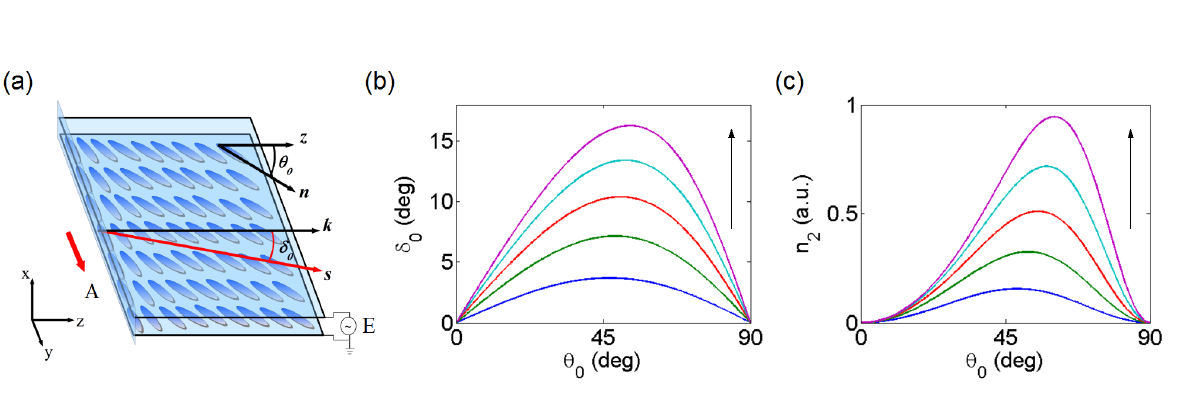
defines the birefringent 0 for various degrees of birefringence and 0